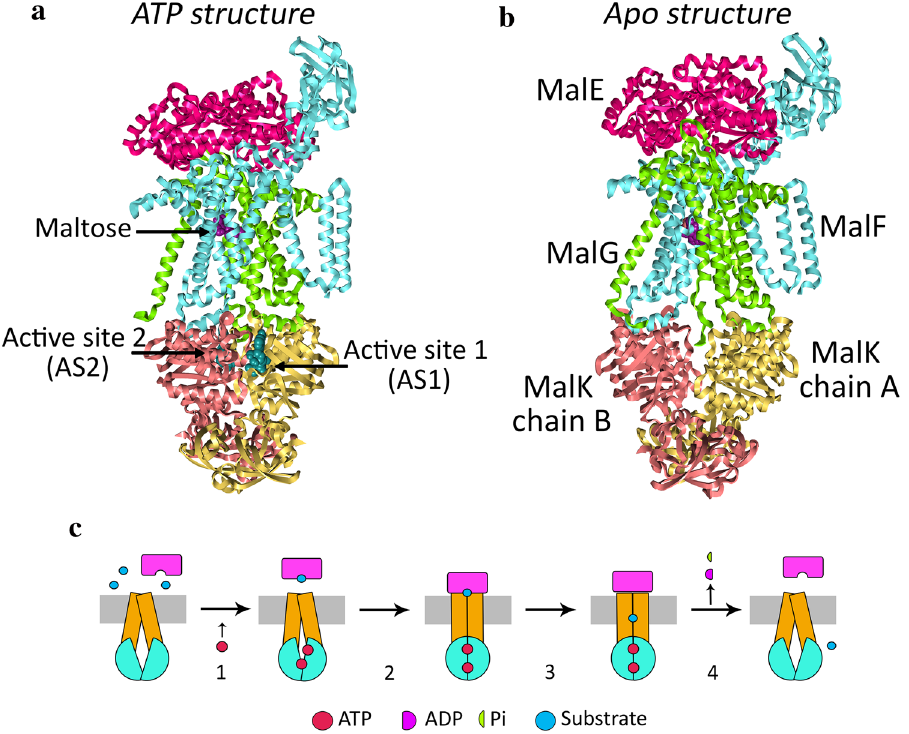
Figure 1. Structures used in this work. ( a ) Initial structure for the simulating the ATP state. This structure contains an ATP analogue bound in the NBDs. The post-hydrolysis state was generated from this structure. PBD code: 3RLF. ( b ) Initial structure used to mimic the protein after nucleotide exit. This structure reflects the pre-translocation state and can be used to extrapolate about the state after nucleotide exit. PBD code: 3PV0. The MalE is represented in bright pink, MalF in cyan, MalG in green and MalK in yellow and salmon. ATP is represented in teal spheres and maltose in purple spheres. ( c ) Transport cycle in the maltose importer. MalE is represented in purple, the TMDs in orange, the NBDs in cyan, ATP in red spheres, maltose as a blue sphere and ADP and Pi as purple and green semi-circles. 1- ATP binding and MalE loading with maltose. 2- MalE